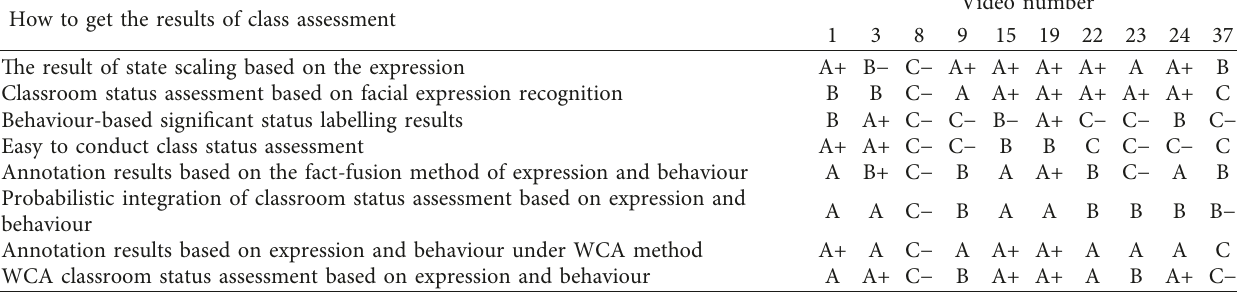
Table 5: Comparison of classroom teaching evaluation results.